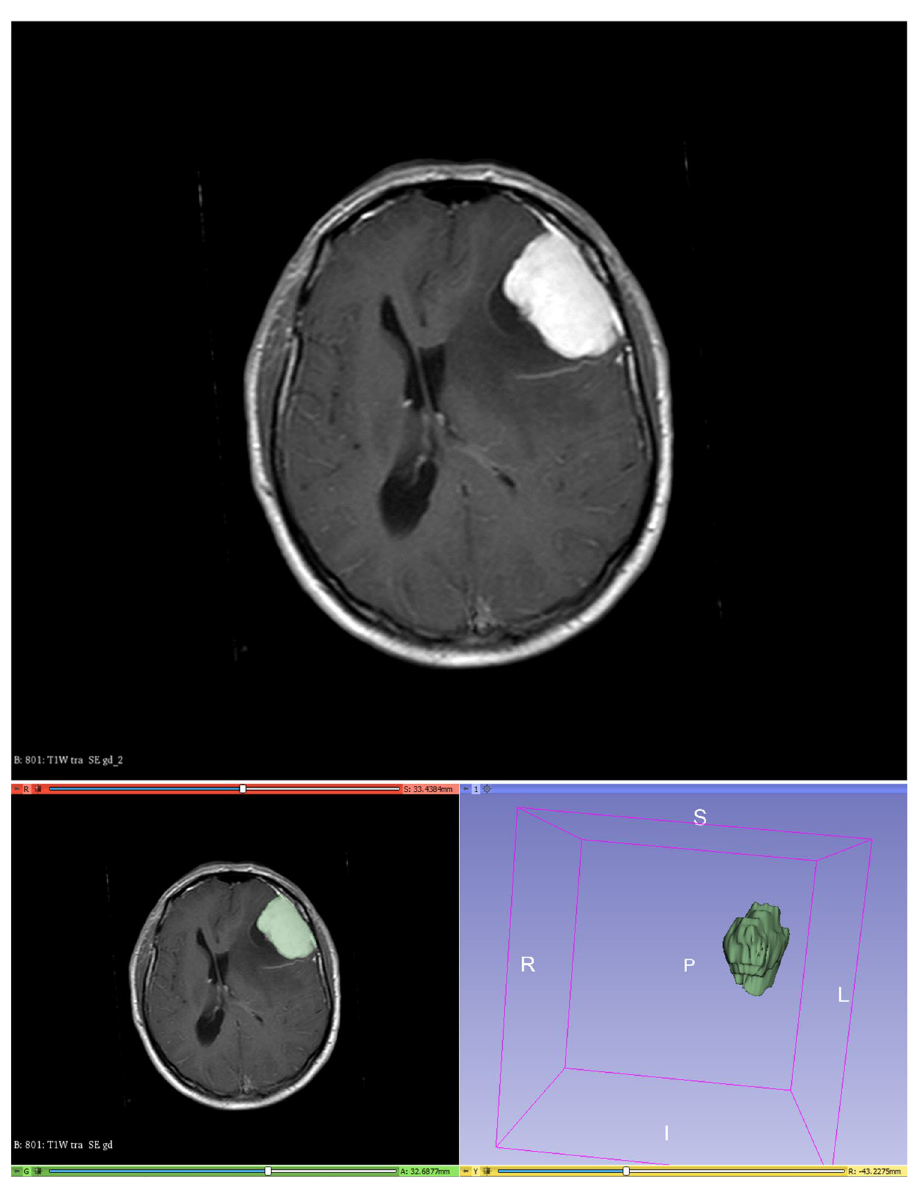
Figure 1. Convexity meningioma of the left hemisphere (above); semi-automatic segmentation with 3D Slicer